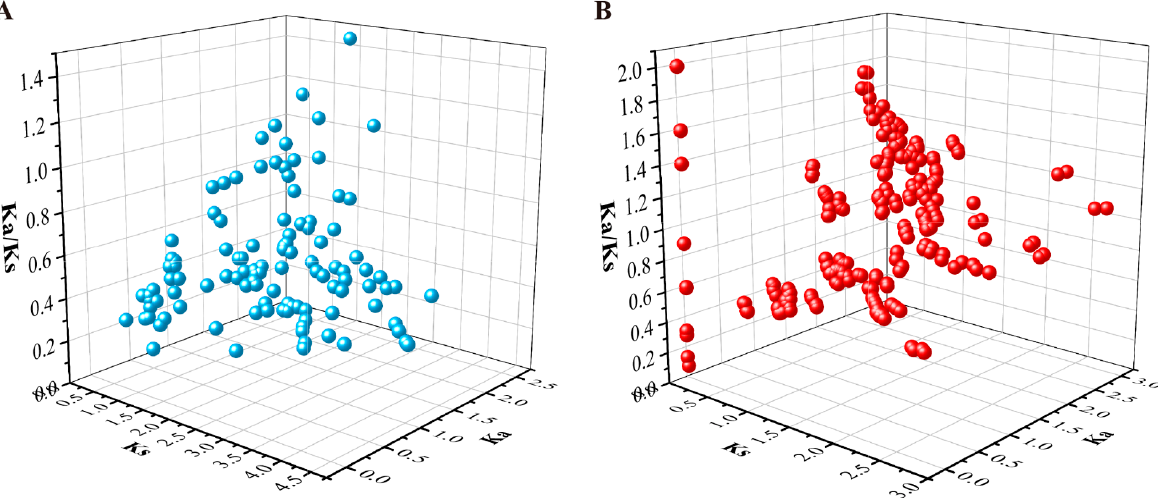
Figure 4. Evolutionary selection pressure analysis of the PP2C homologous gene pairs. Note: The X axis represents the Ka value, the Y axis represents the Ks value, and the Z axis represents the ratio of Ka to Ks. ( A ) Evolutionary selection pressure analysis of the FvPP2C homologous genes. ( B ) Evolutionary selection pressure analysis of the FaPP2C homologous genes.